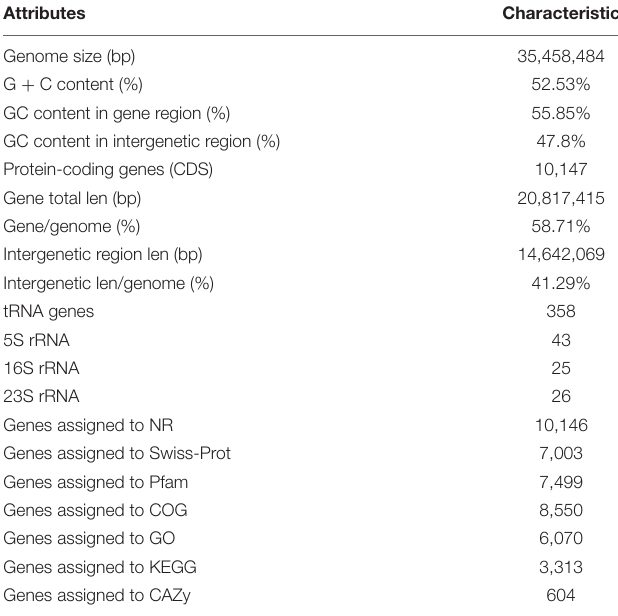
TABLE 8 | The genome features of